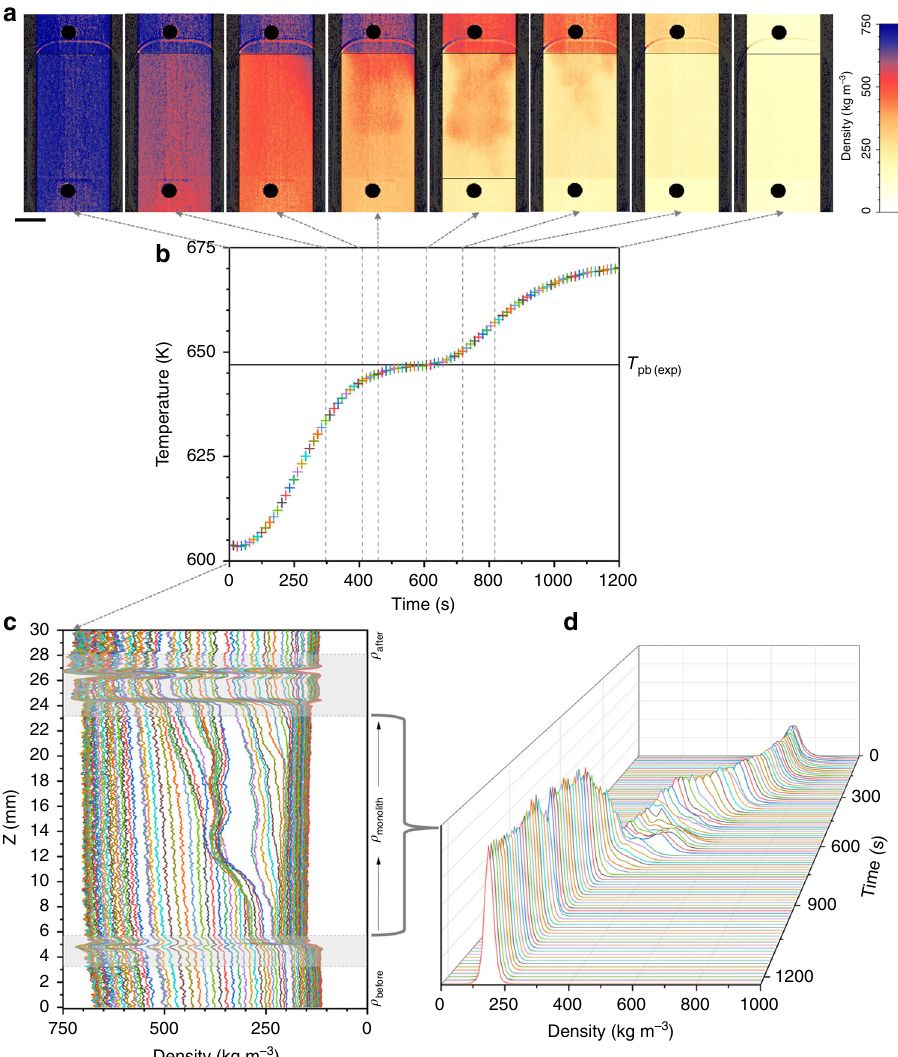
Fig. 3 Time evolution of the system during isobaric heating at 225 bar. a A set of representative color scaled density maps are presented to indicate a few signi fi cant moments: when the color changes from blue to red, then the coexistence of orange reddish with yellow, and then the conversion to pale yellow; the length of the scale bar is 5 mm. b The temperature pro fi le recorded before the monolith with the indication of the temperature of the plateau ( T pb(exp) ). c Vertical densities pro fi les and d densities histograms for the monolith region. Each point in the temperature pro fi le corresponds to a line in the density pro fi le and a density histogram. Source data for b – d are provided as a Source Data fi